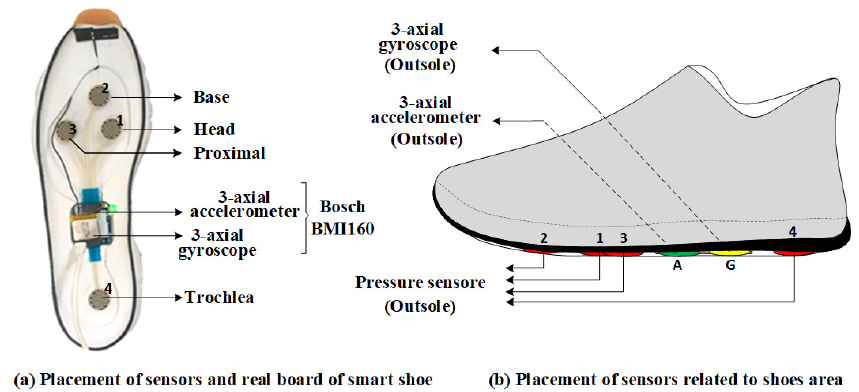
Figure 2. The placement of sensors: eight pressure sensors were mounted on the outsole of the shoes as well as two Bosch BMI160 sensors. Each Bosch BMI160 sensor consists of a three-axis accelerometer and a three-axis gyroscope, respectively. There were 12 sensors in total mounted no the outsole of both the left and the right shoes. ( a ) The position of sensors on the real board of smart shoe. ( b ) The position of sensors outsole of the smart